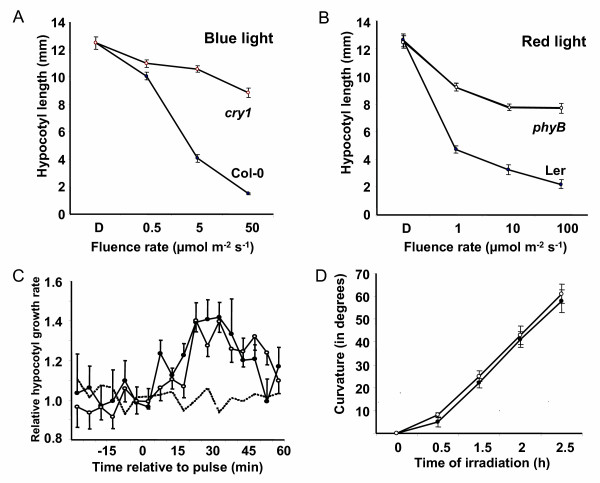
Norlux arrays induce typical light responses during early seedling development. A) Blue light fluence-rate response experiments demonstrate the effect of increased fluence rates of blue light on stem growth after 72 h (filled circles; n = 60). The cry1 mutant was tested for comparison (n = 62). B) Fluence-rate/response experiments were performed using red light and demonstrate growth inhibition in wild-type seedlings (filled circles; n = 70) compared to phyB mutants (open circles; n = 60). C) The stem-stimulatory effect of a short single pulse of green light is shown (open circles) and compared to previously published results ([17]; filled circles), and dark growth kinetics (dotted line). D) Phototropic curvature in response to blue light was measured in etiolated seedlings (filled circles; n = 21) and compared to results from previous reports ([30]; open circles). These findings demonstrate how the HEX arrays and the designs presented herein have utility in study of integration of light information from multiple photosensory systems.